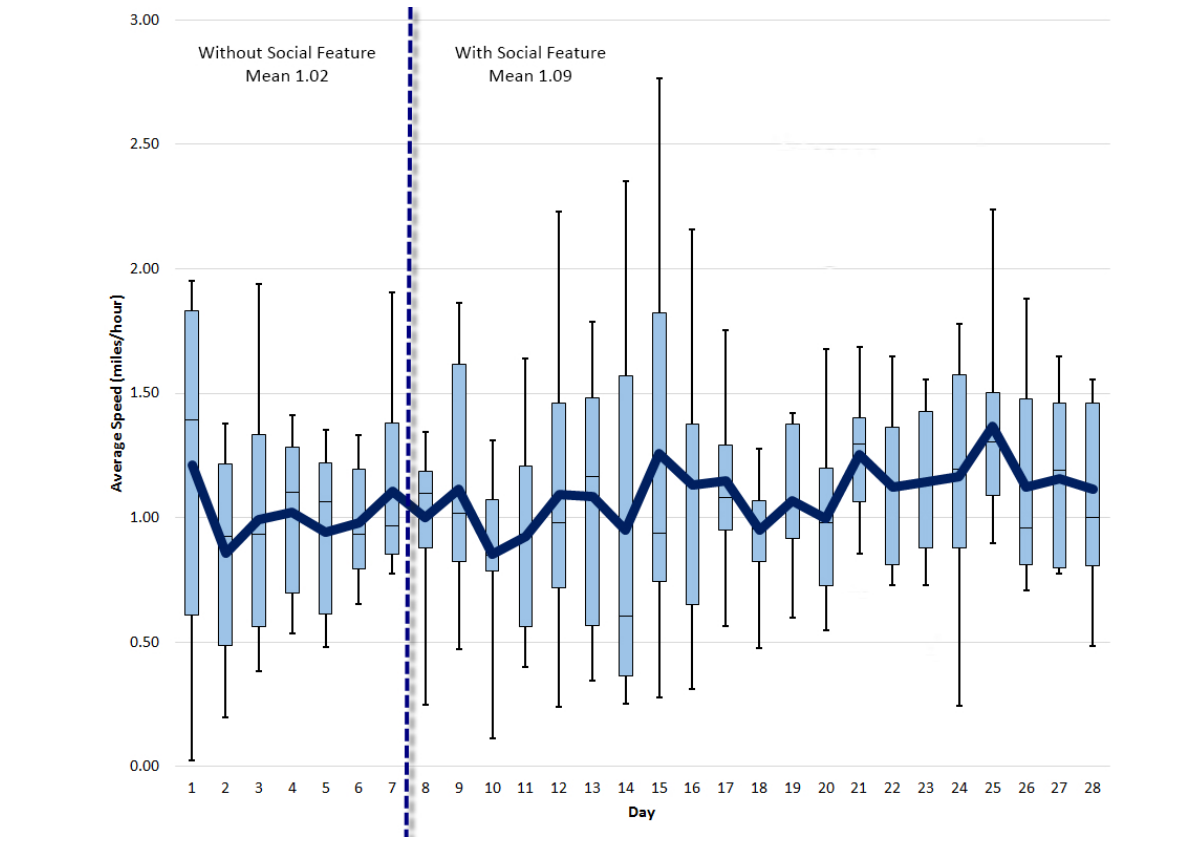
Figure 9. Average speed comparison between baseline and social intervention.